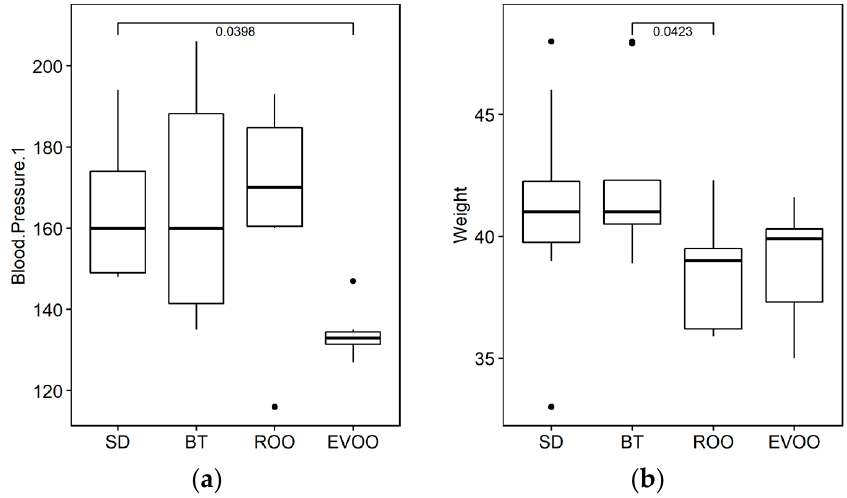
Figure 1. Physiological means found to be statistically different with a signification at 5% (( a ), blood pressure, p = 0.004) and 10% (( b ), weight, p = 0.057) after six weeks of diet. BT, butter enriched diet; EVOO, extra virgin olive oil enriched diet; ROO, refined olive oil diet; SD, standard diet.